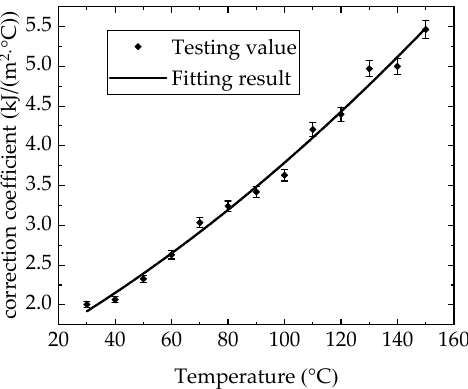
ffi cient varying with